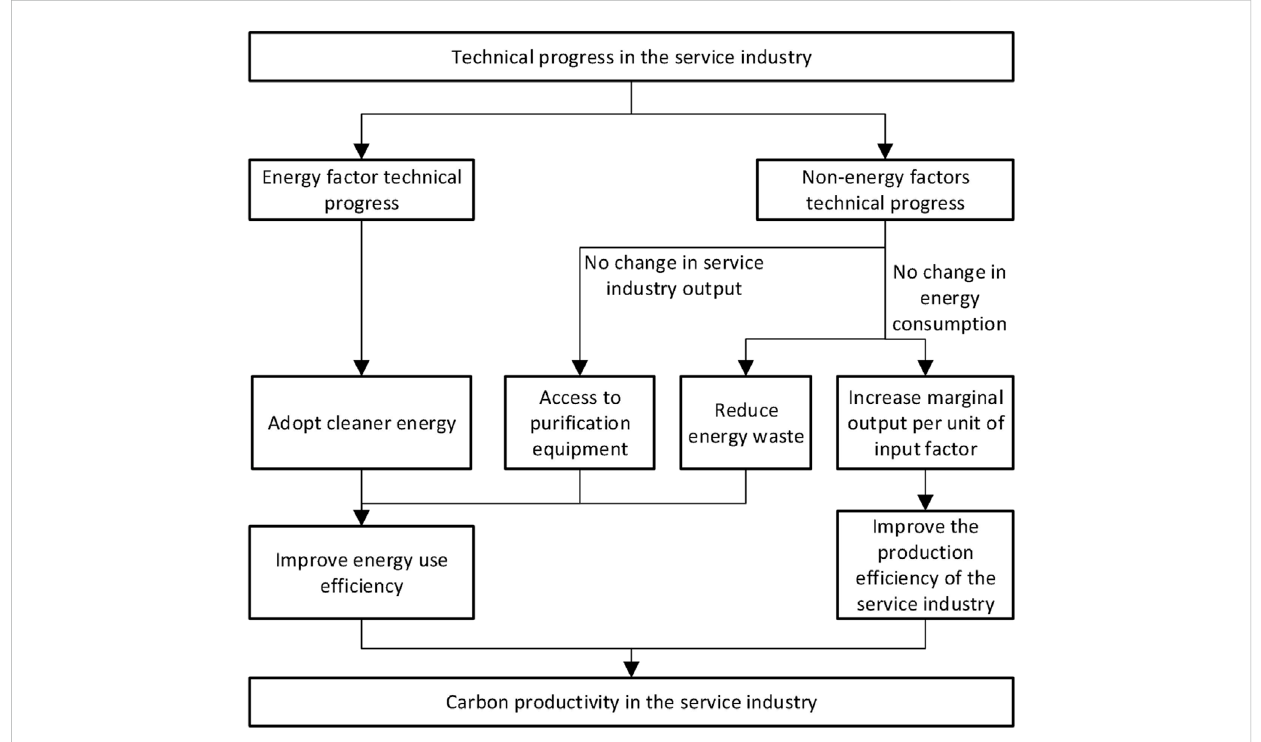
FIGURE 1 Mechanism analysis of impact of technical progress on carbon productivity in the service